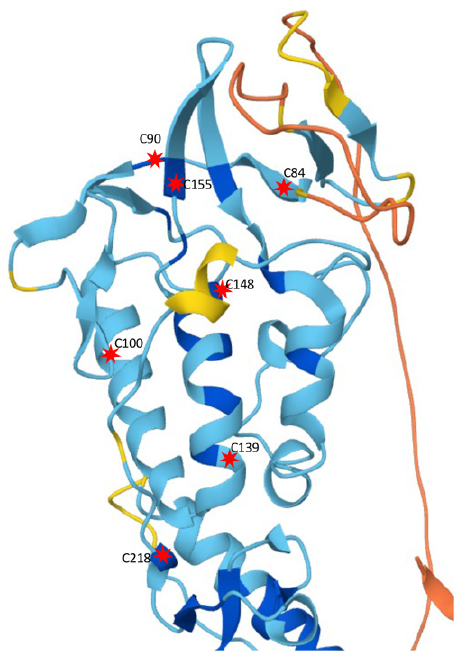
Figure 3. SMO ECD structure. Shown here is the structure of SMO ECD domain, adopted from the AlphaFold protein structure database. Critical cysteins are indicated by red stars with the positions numbered.